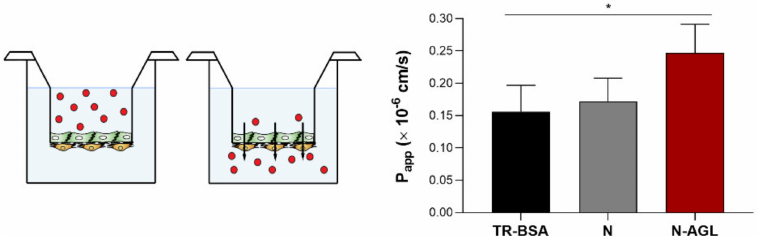
Figure 6. Permeability of the cargo Texas red-BSA (TR-BSA) alone and encapsulated into non-targeted (N) and ascorbic acid-glutathione-leucine-targeted (N-AGL) nanoparticles across the BBB co-culture model. Papp: apparent permeability coefficient. Values presented are means ± SD. Statistical analysis: one-way ANOVA followed by Dunnett’s posttest; * p < 0.05 compared to the TR-BSA group; n = 4.